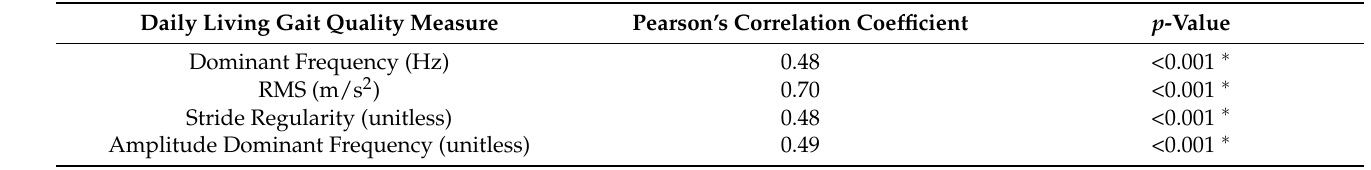
Table 8. Correlations between the gold standard and the DCNN model in the OA cohort.